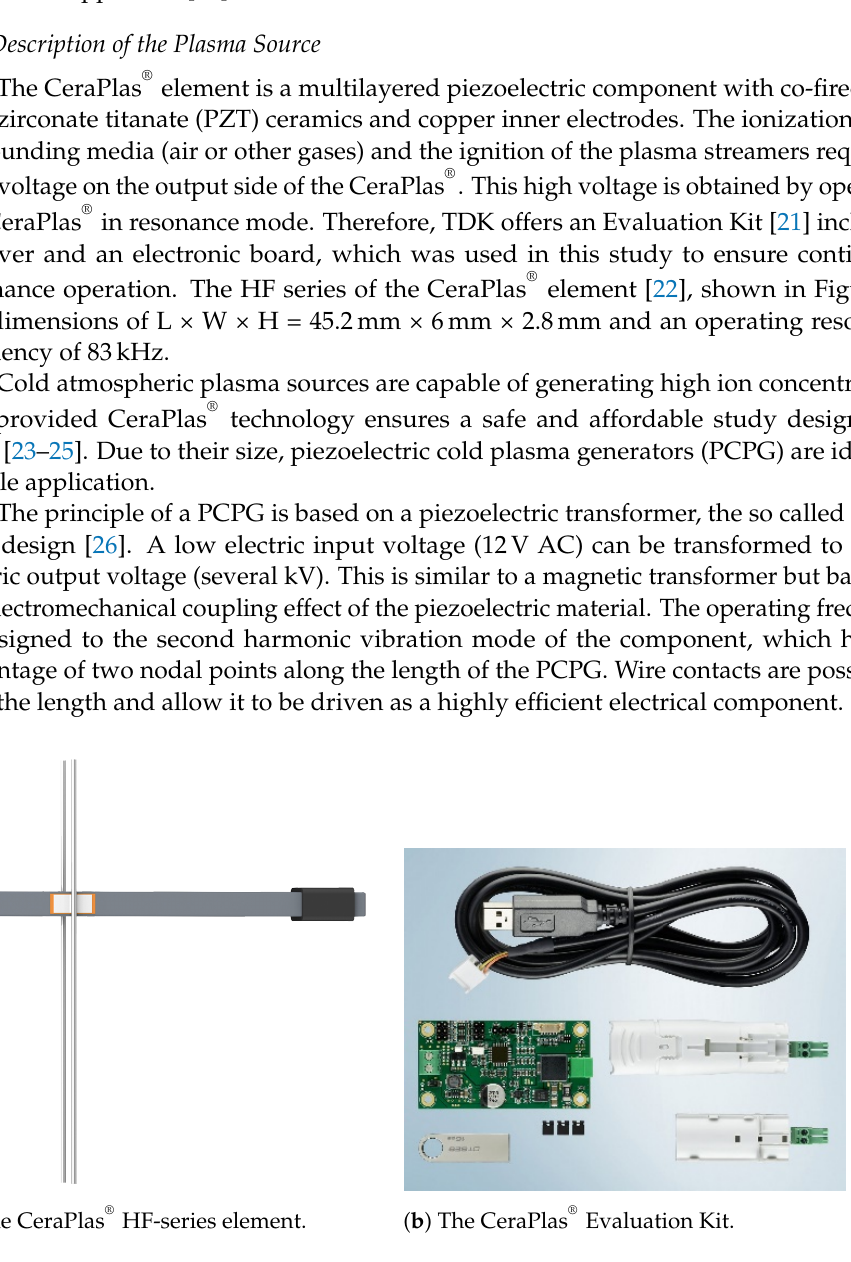
Figure 1. The CeraPlas ® as available from